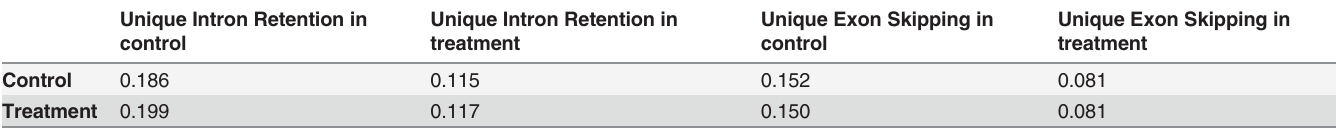
Table 2. Exons involved in alternative splicing exhibit little difference in DNA methylation between control and